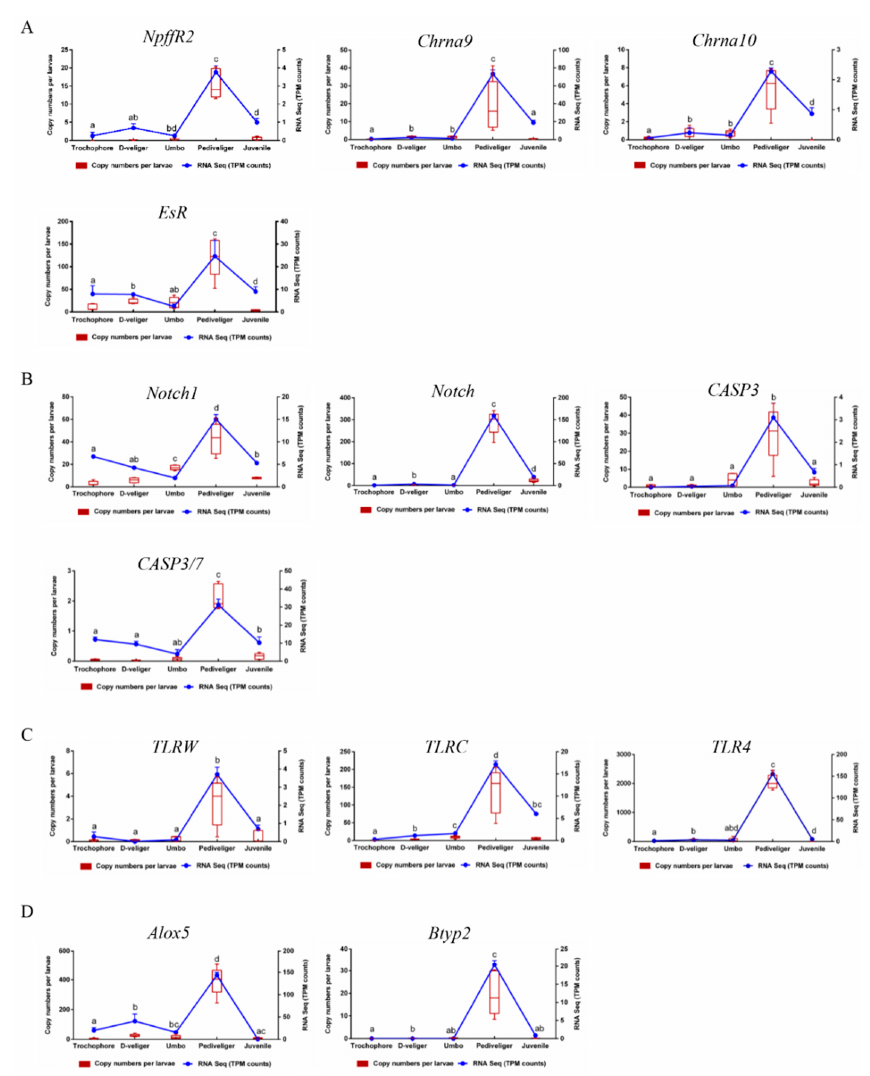
Figure 5. Comparison of gene expression among five developmental stages by RNA-seq and qPCR analysis. Boxplots represent the copy numbers per larvae performed by qPCR. Blue line represents the expression levels of the TPM counts assessed by RNA-seq. Analysis genes were related to neuroendocrine ( A ), growth and apoptosis ( B ), immune ( C ), and others ( D ). NpffR2 : Neuropeptide FF receptor 2; Chrna9 : neuronal acetylcholine receptor subunit alpha-9 isoform X1; Chrna10 : neuronal acetylcholine receptor subunit alpha-10-like; EsR : estrogen receptor; Notch1 : neurogenic locus notch homolog protein 1-like isoform X2; Notch : putative neurogenic locus Notch protein-like; CASP3 : caspase-3-like 1 protein, partial; CASP3/7 : caspase 3/7-4; TLRW : toll-like receptor W; TLRC : toll-like receptor c; TLR4 : toll-like receptor 4 isoform X2; Alox5 : arachidonate 5-lipoxygenase isoform X1; Btyp2 : byssal tyrosinase-like protein 2. Different letters indicate statistically significantly different copy numbers of the qPCR analysis ( p <